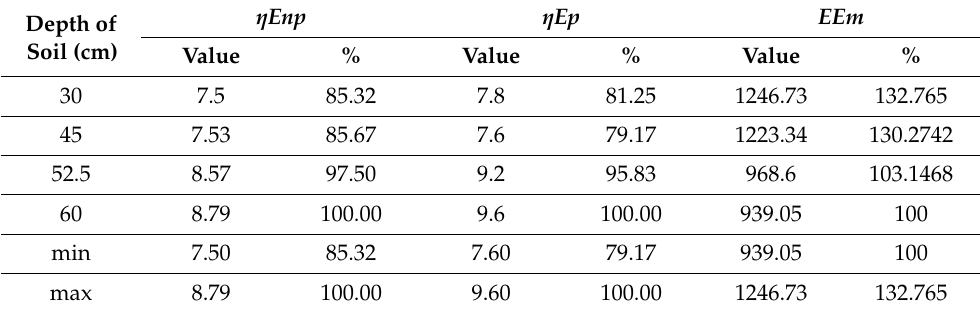
Table A12. Average emissions and efficiency of crops according to the depth of the